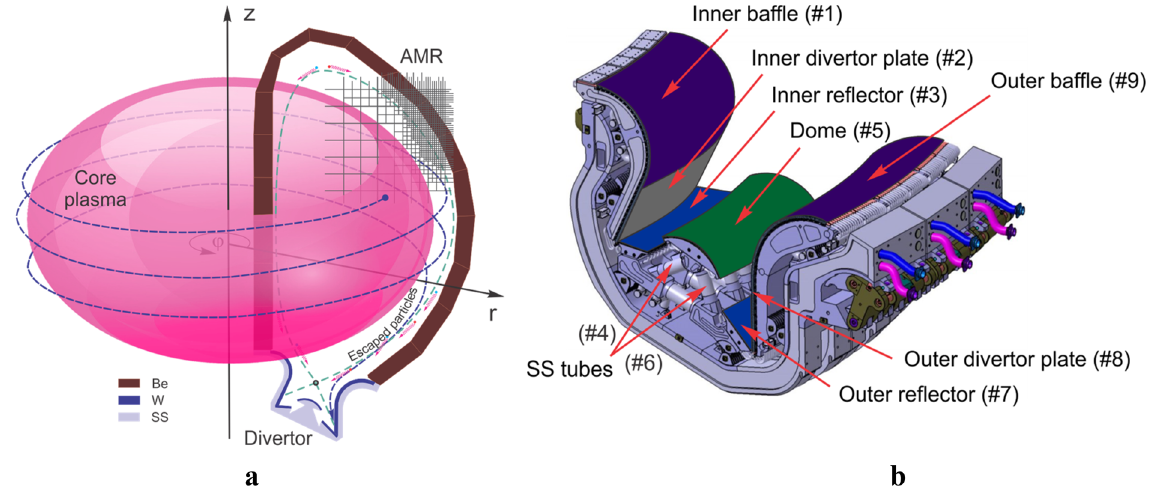
Figure 1. 3D schematic illustration of ITER components and coordinate system ( a ), and divertor and nearby component surfaces ( b ) implemented in HEIGHTS package. The images were prepared using CorelDRAW Graphics Suite